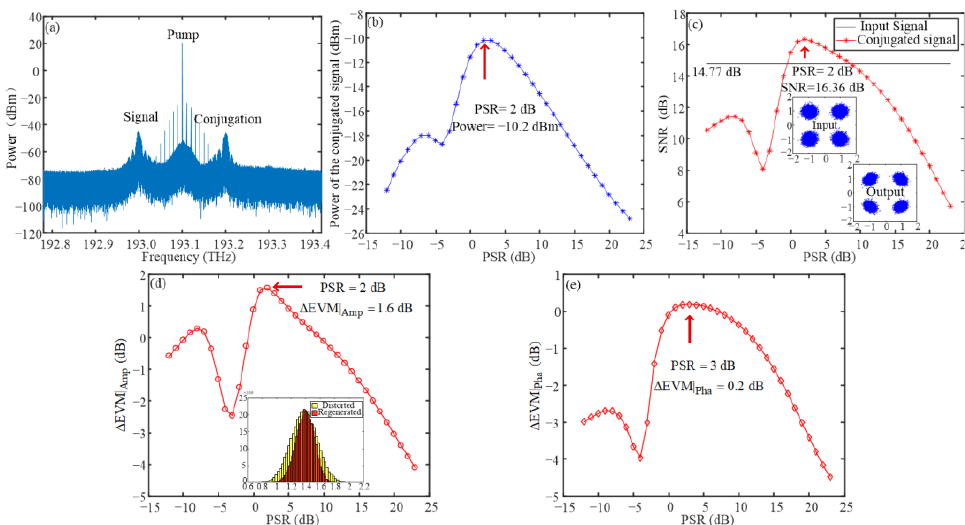
Figure 5. ( a ) Spectrogram in YF case; ( b ) power curve of the conjugated signal with PSR; ( c ) relation between SNR and PSR; ( d ) the amplitude EVM gain ΔEVM| Amp ; and ( e ) the phase EVM gain ΔEVM| Pha on the input PSR.